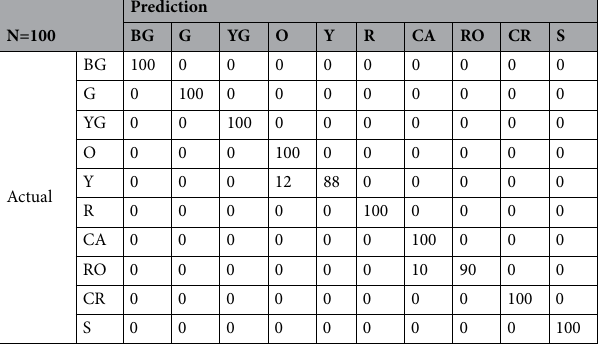
Table 2. Confusion matrix (%) of final 1DCNN for classification of 10 types of fluorescent beads from non He-Ne corrected interferograms with N=100